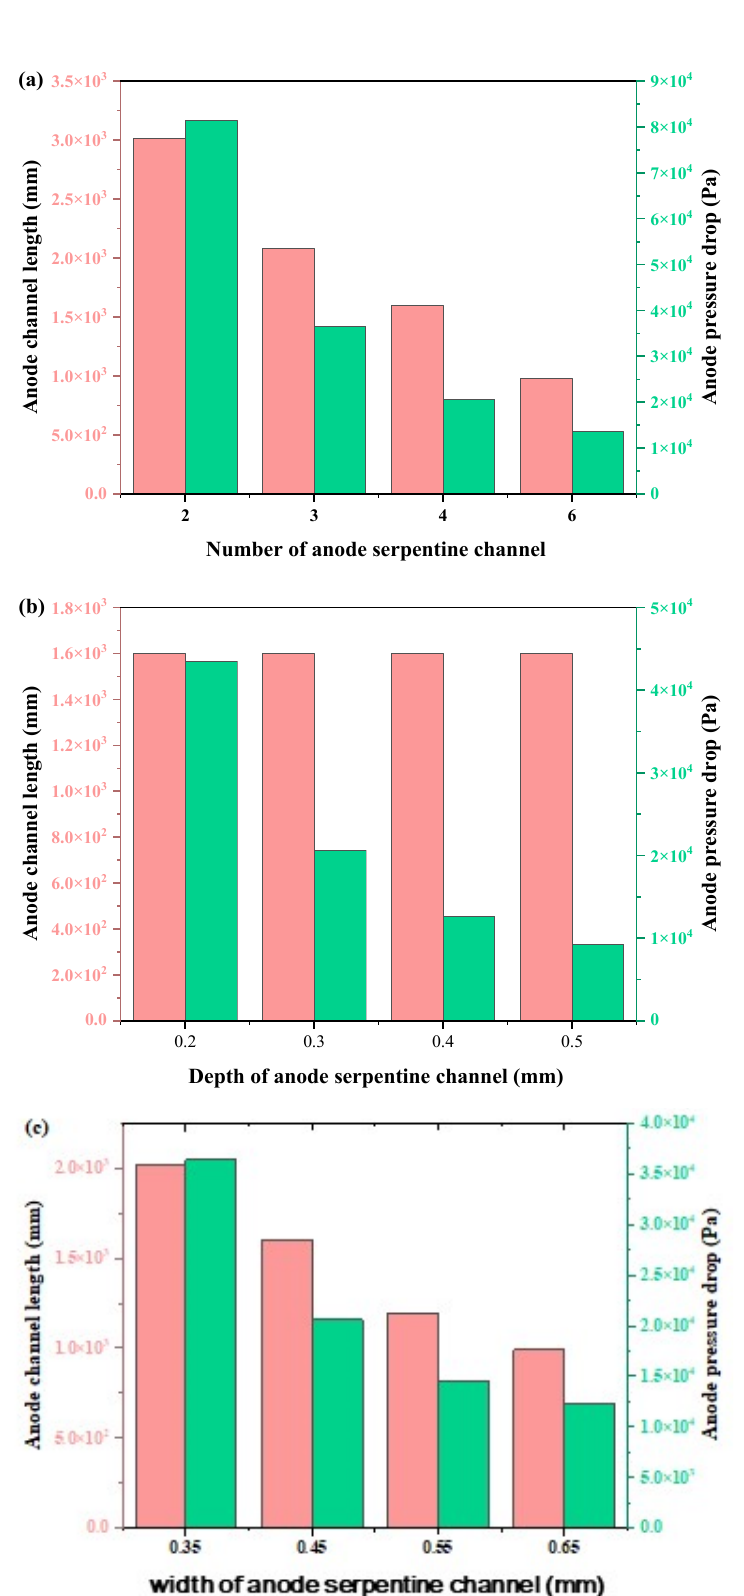
Figure 2. Calculation results of anode pressure drop and channel length of the cell with different anode serpentine channel parameters: ( a ) number, ( b ) depth, and ( c ) width.